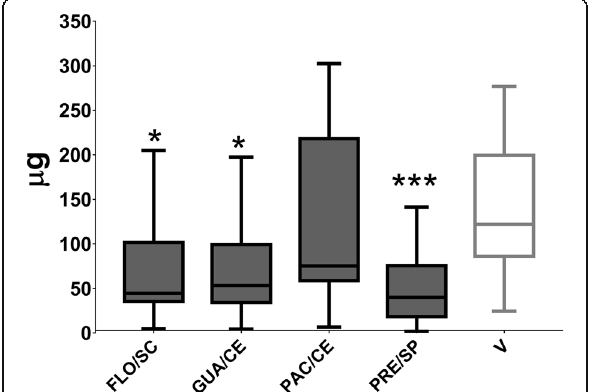
Fig. 5 Effect of FLO/SC, GUA/CE, PAC/CE, and PRE/SP extracts on GtfB activity. The data described are median (traces) and interquartis (boxes). The error bars represent the maximum and minimum values. Asterisks indicate statistically significant differences from a specific extract versus vehicle control (V), where: ** p < 0.0136 and *** p = 0.0002 (Kruskal-Wallis test, followed by Dunn ’ s multiple comparison test). Only the PAC / CE extract did not affect GtfB activity ( p = 0.6032). The colors of the bars of the graph represent the variety to which the extracts belong, being, in dark gray color: var. sylvestris